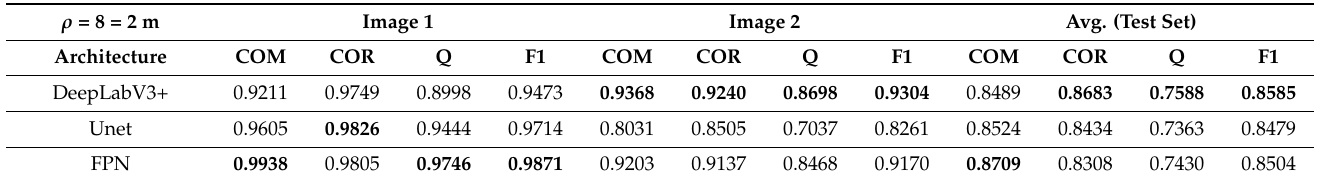
Table 5. Rural road extraction quantitative results for a ρ = 8 (using the Zhang–Suen thinning algorithm)—values in bold represent the road detection algorithm with the best performance in each parameter.